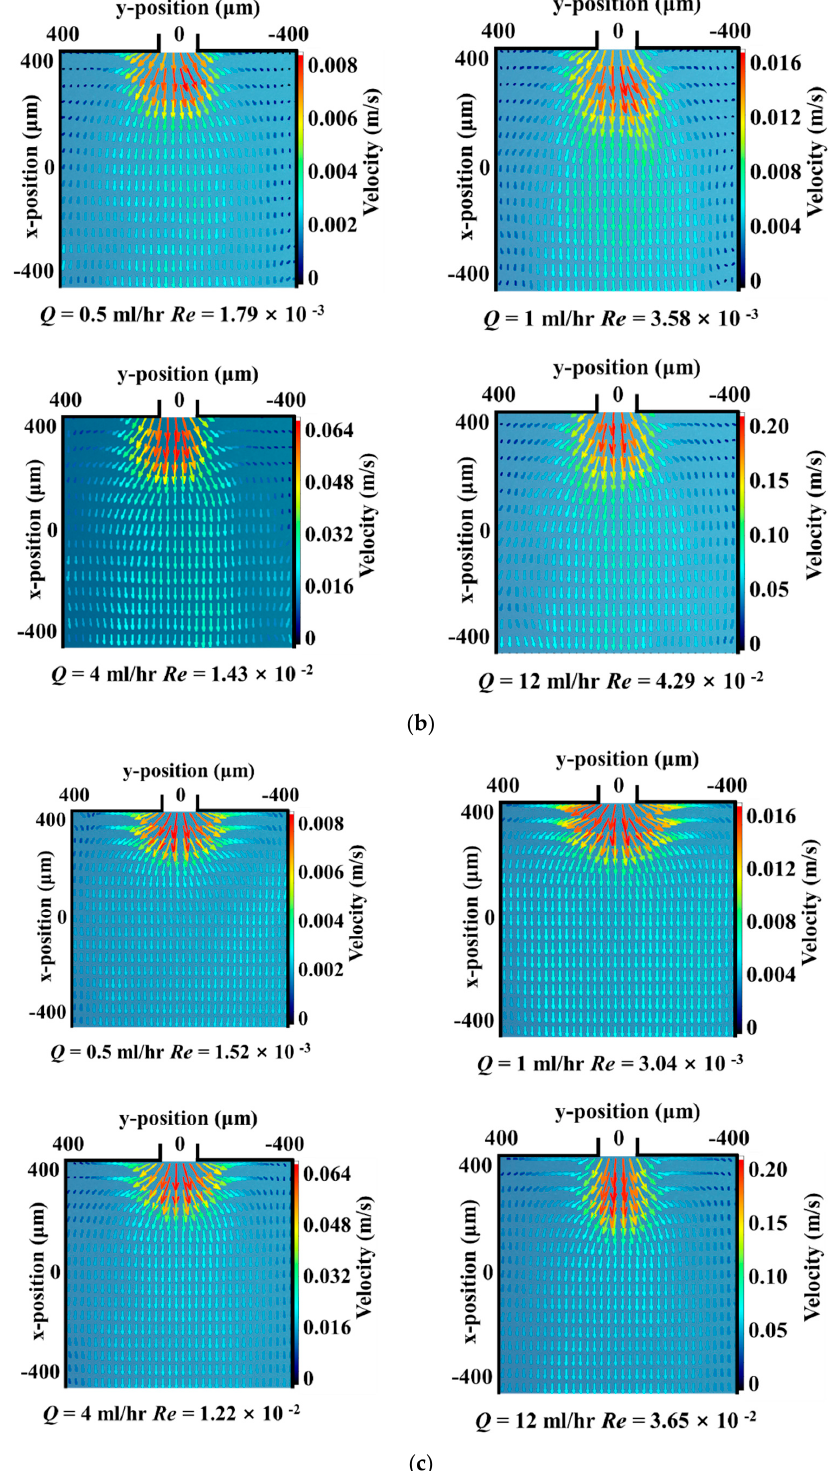
Figure 3. The development of flow patterns for the flow of ( a ) Newtonian fluid, ( b ) HPAM solution and ( c ) VES fluid in infinite length pore-throat structure, flow rates range from 0.5 mL/h to12 mL/h.